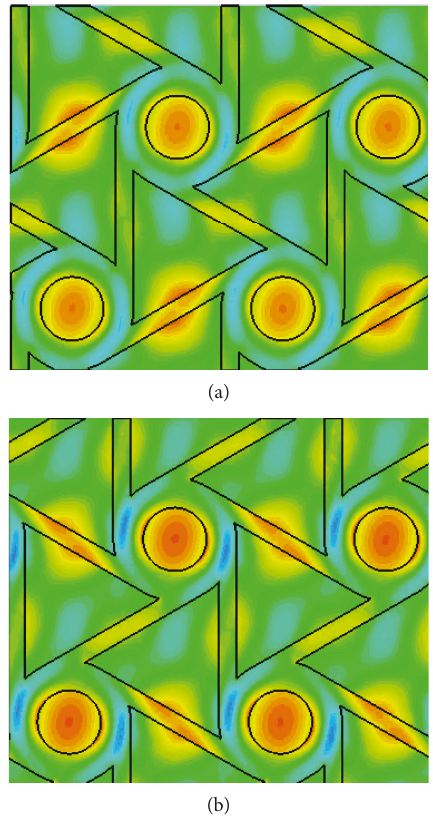
Figure 6: Electric energy density for a vertical polarized plane wave, at a frequency of 10.59GHz: (a) fi rst layer; (b) second layer.